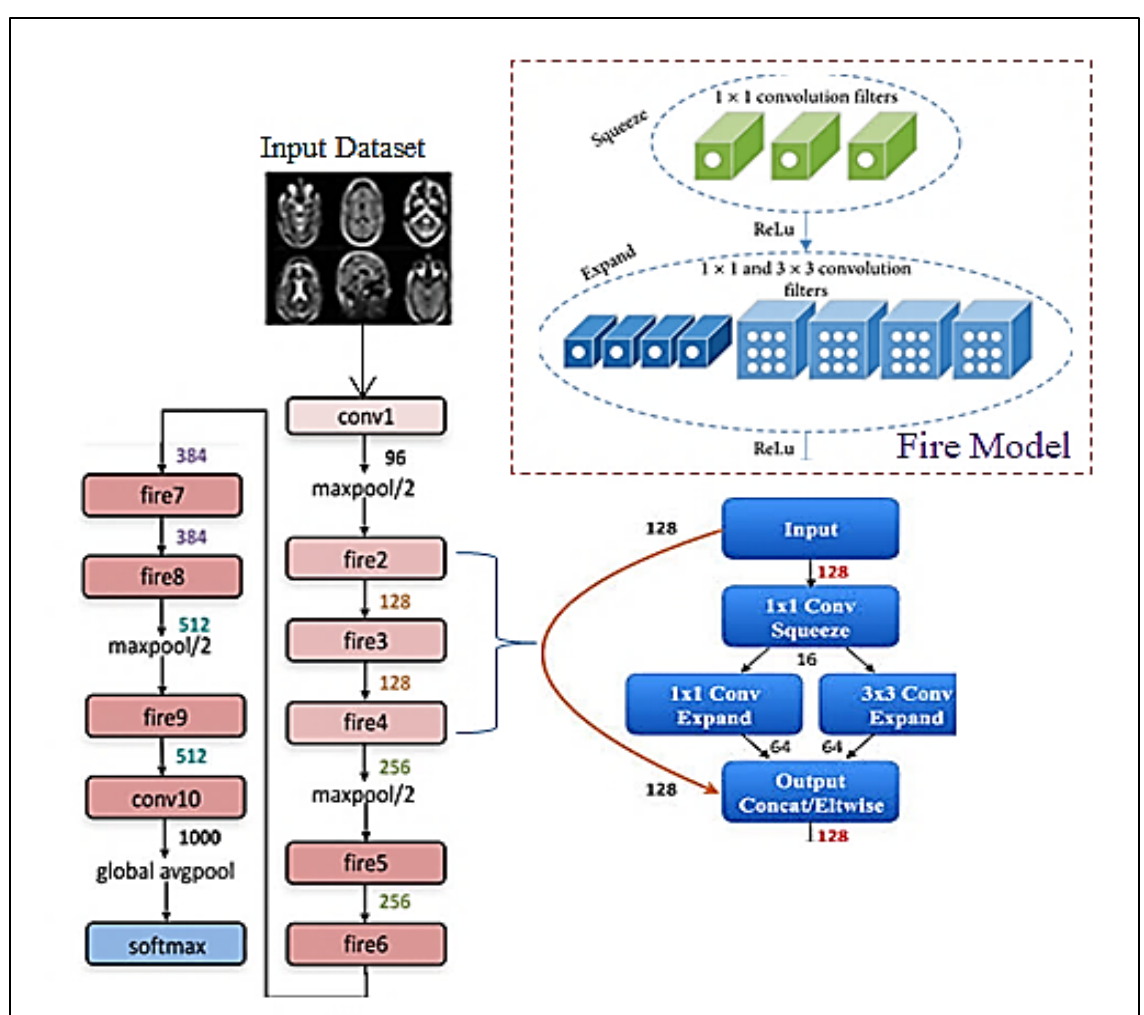
Figure 2. SqueezeNet architecture with a squeeze and expand process. Table 1. Details of layers of the SqueezeNet